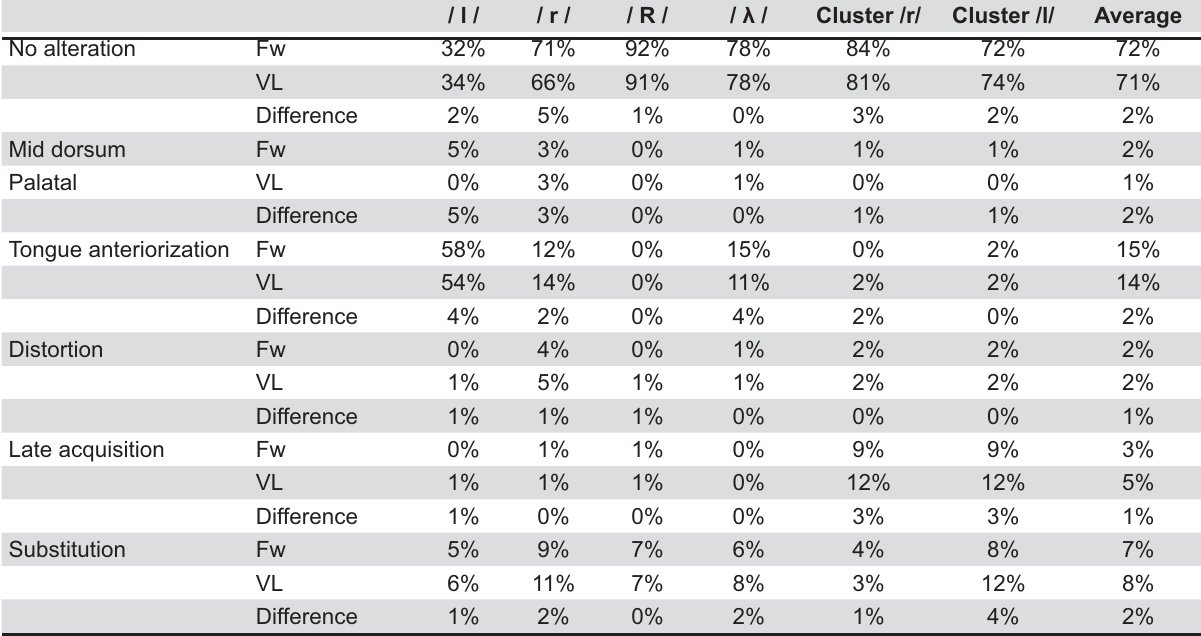
Fw: Samples of patients who received palatoplasty with Furlow technique VL: Samples of patients who received palatoplasty with von Langenbeck technique Difference: difference in % between groups Fw and VL